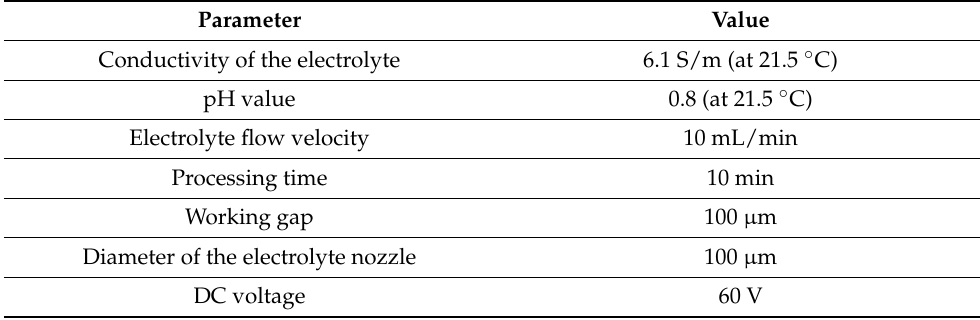
Table 1. Process parameters of jet-based anodization